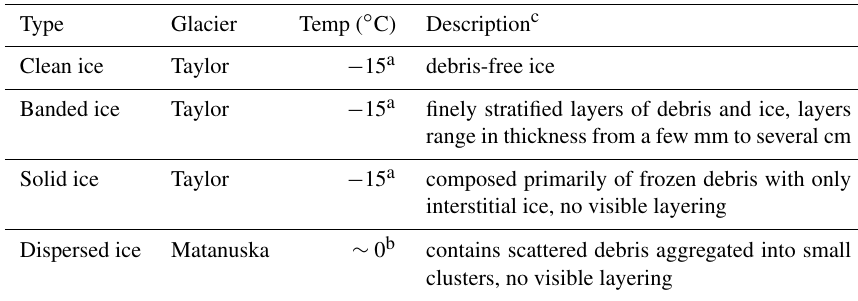
Table 1. Description of basal ice types collected in this study. Type Glacier